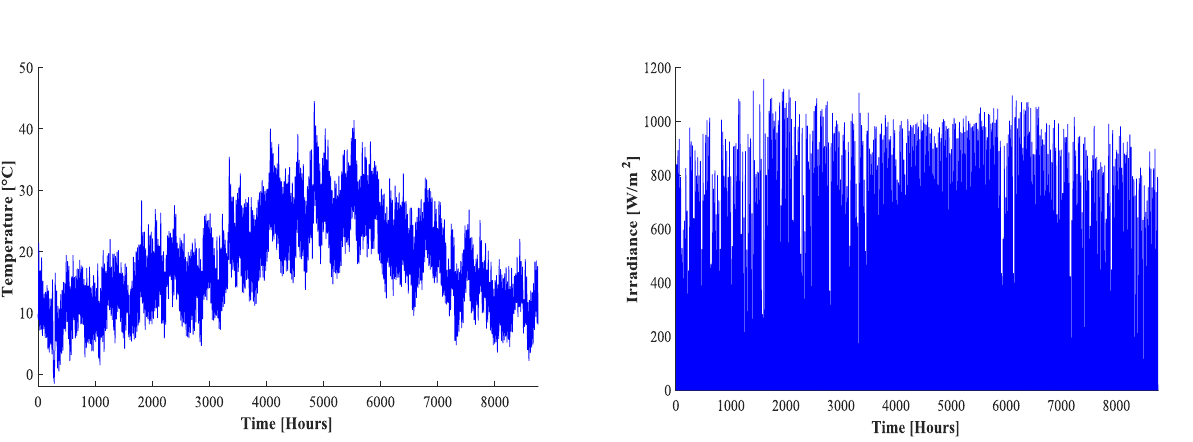
Fig. 13 Annual database of the irradiance [W/m 2 ]